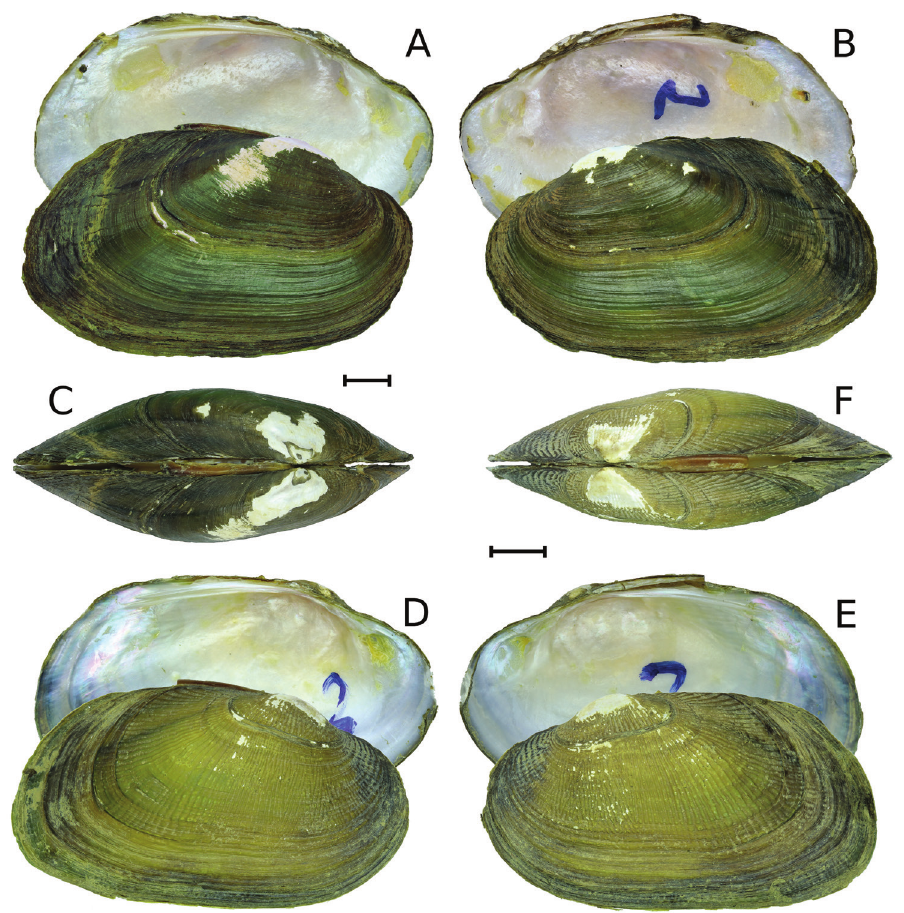
Figure 2. Specimens of Indonaia andersoniana (Nevill, 1877) and I. subclathrata (Martens, 1899) from My- anmar [RMBH biv450_2 and RMBH biv347_2, respectively]. A, B Shell of I. andersoniana , lateral view: inner side of the left valve and outer side of the right valve ( A ); vice versa ( B ) C shell of I. andersoniana , dor- sal view D, E shell of I. subclathrata , lateral view: inner side of the left valve and outer side of the right valve ( D ); vice versa ( E ) F shell of I. subclathrata , dorsal view. Scale bar: 5 mm. (Photos: Ekaterina S. Konopleva). shell labelled as Unio rectangularis and deposited in the MSNG studied here corresponds in dimensions to the specimen described by Tapparone-Canefri. The original label (Fig. 1D) also affirms that this shell is the holotype of Unio rectangularis designated by